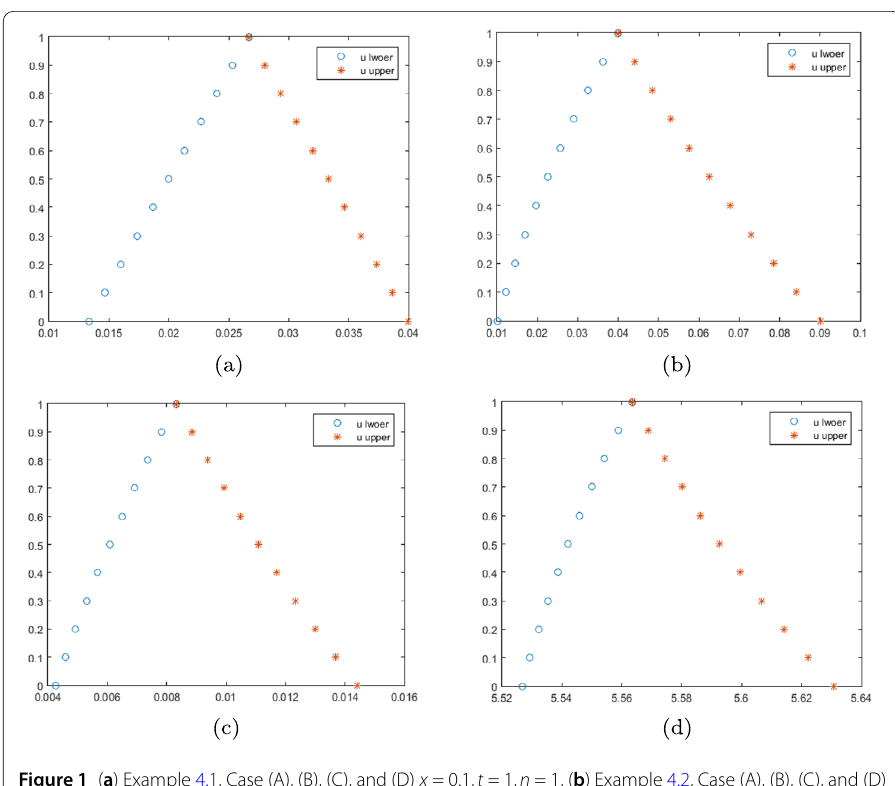
Figure 1 ( a ) Example 4.1, Case (A), (B), (C), and (D) x = 0.1, t = 1, n = 1, ( b ) Example 4.2, Case (A), (B), (C), and (D) x = 0.001, y = 1, t = 0, n = 2, ( c ) Example 4.3, Case (A), (B), (C), and (D) x = 0.02, y = 0, z = 0, t = 0.7, n = 3, ( d ) 5 = 0.4, x 6 = 0.5, x 7 = 0.6, x 8 = 0.7, x 9 = 0.8, x 10 = 0.9, x 11 = 1), t = 0.0002, n =